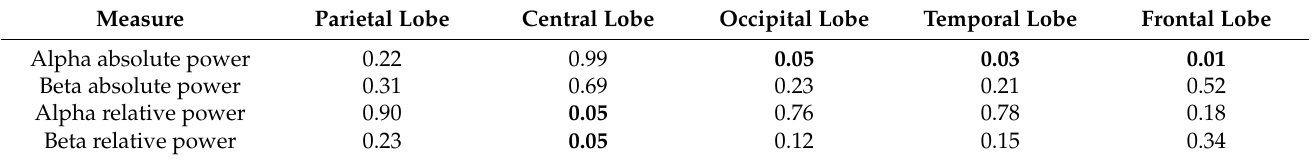
Table 11. Friedman test. Results of the p -value between all the games by cerebral lobes. P -values below 0.05 are considered statistically significant.